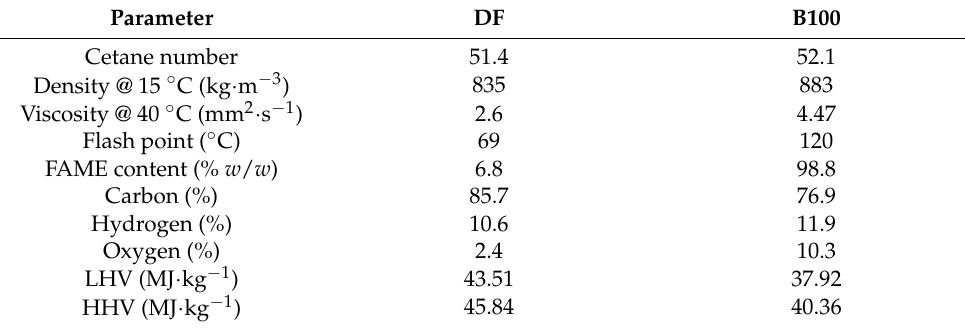
Table 2. Chosen characteristics of the tested